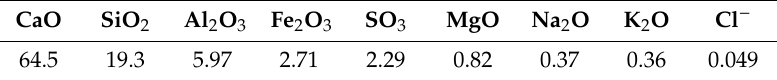
Table 2. Chemical compositions of cement CEM I ( % )